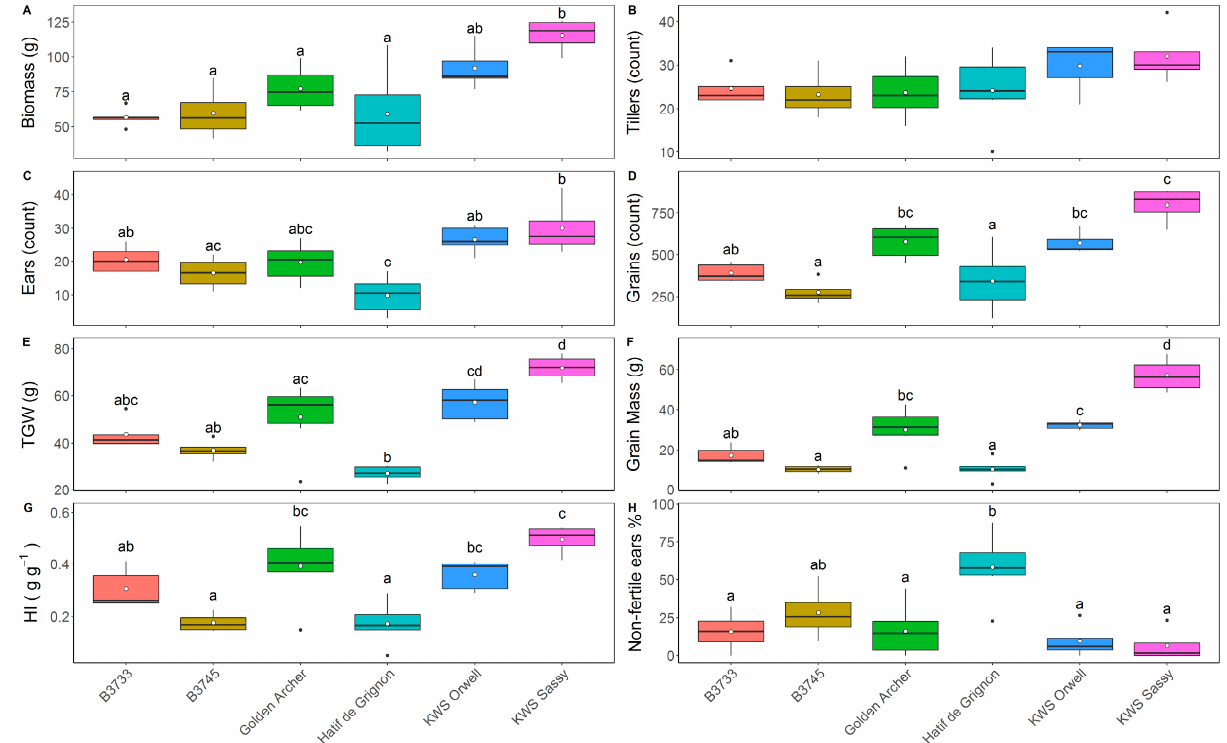
Figure 4. Harvest at maturity (162 days after sowing) of 6 barley cultivars (the wild barleys B3733 and B3745, the landraces Golden Archer and Hatif de Grignon and the elite cv’s KWS Orwell and KWS Sassy) grown in a polytunnel; ( A ) Total above-ground biomass plant − 1 . ( B ) Tiller number plant − 1 . ( C ) Number of ears plant − 1 . ( D ) Number of grains ear − 1 . ( E ) Thousand Grain Weight plant − 1 . ( F ) Grain mass plant − 1 . ( G ) Harvest Index (=Grain mass/Total biomass). ( H ) Non-fertile tillers as a percentage of all tillers. Data shown as box and whisker plot, means as white points, N = 5–6, Identical letters indicate no significant differences between means based on Tukey’s test of model outputs at p = 0.05.